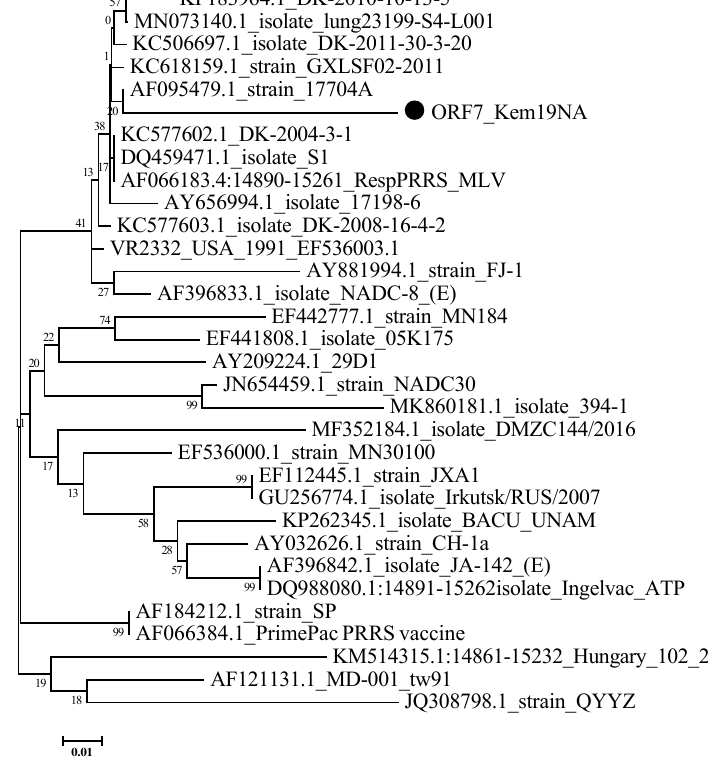
Figure 3. Phylogenetic trees of PRRSV1 strains based on complete ORF7 nucleotide sequences. Bootstrap confidence limits are presented at each node. The Kem19EU strain is designated by a circle ( • ). Strains are designated in the following format: GenBank accession number_ name.